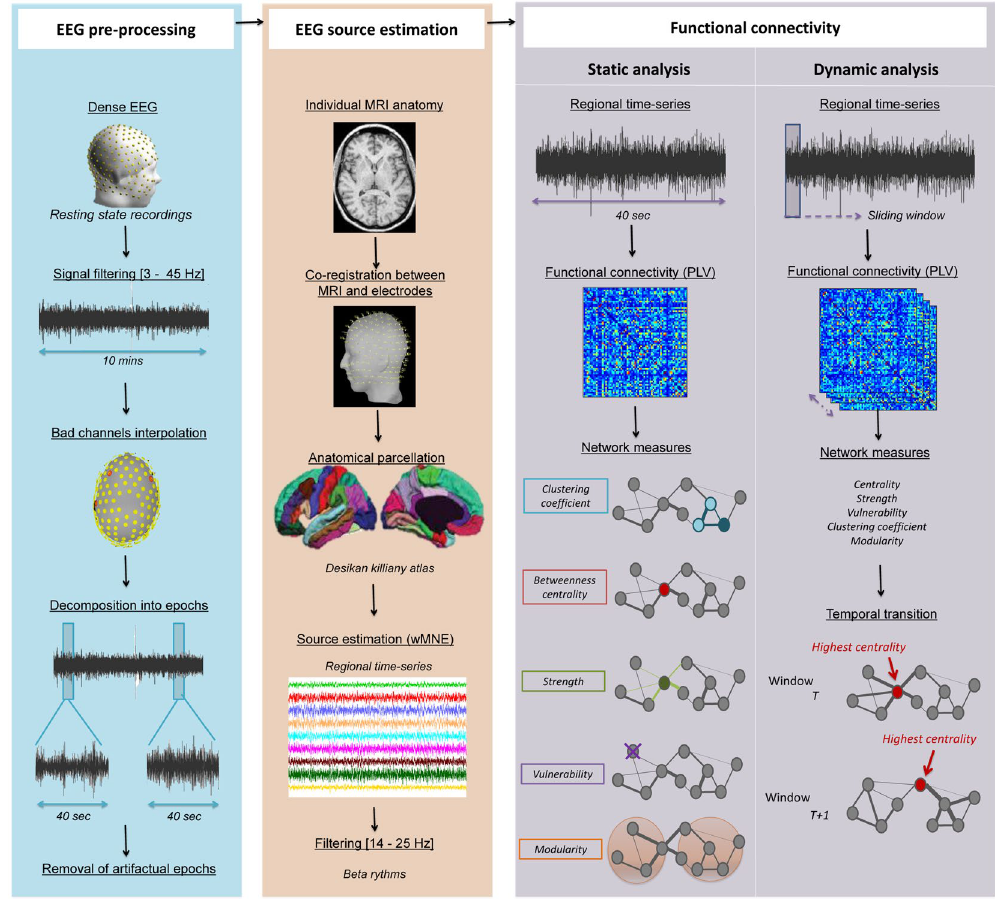
Figure 1. Structure of the investigation. left : Pre-processing of the dense-EEG data by interpolating channels and removing artifactual epochs, middle : Estimation of the EEG cortical sources using the weighted norm estimation method (wMNE). This step was followed by a projection of the source signals on the Desikan- killiany atlas, right : Quantification of the functional connectivity between the regional time series using the phase locking value (PLV). Two analyses were performed: (i) the static analysis in which PLV was computed over a segment of 40 s and (ii) the dynamic analysis in which PLV was computed over a 300 ms sliding window. The networks were then characterized by different graph measures (centrality, strength, vulnerability, clustering coefficient and modularity). The temporal transitions between networks/node’s characteristic across time were also